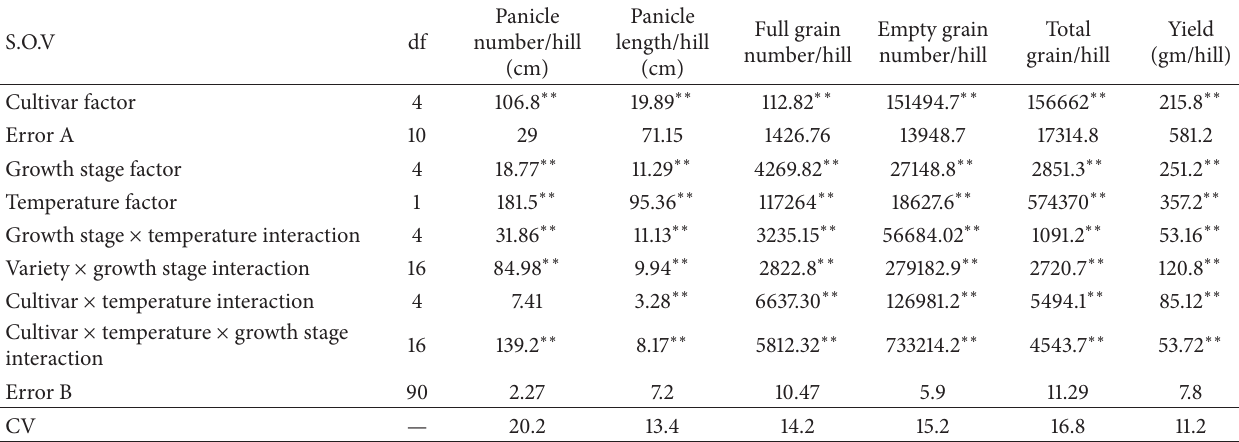
Table 1: Sources of variations of yield and yield components.